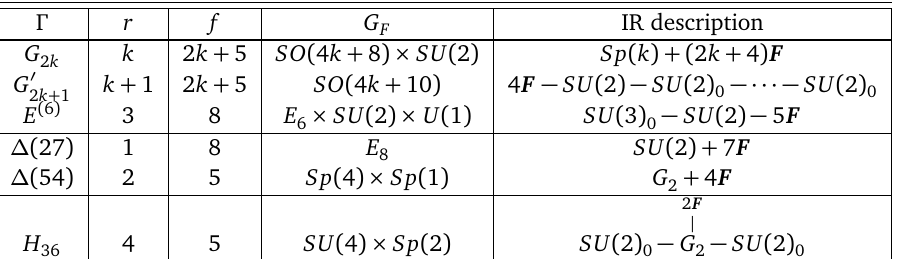
with known 5d gauge theory X